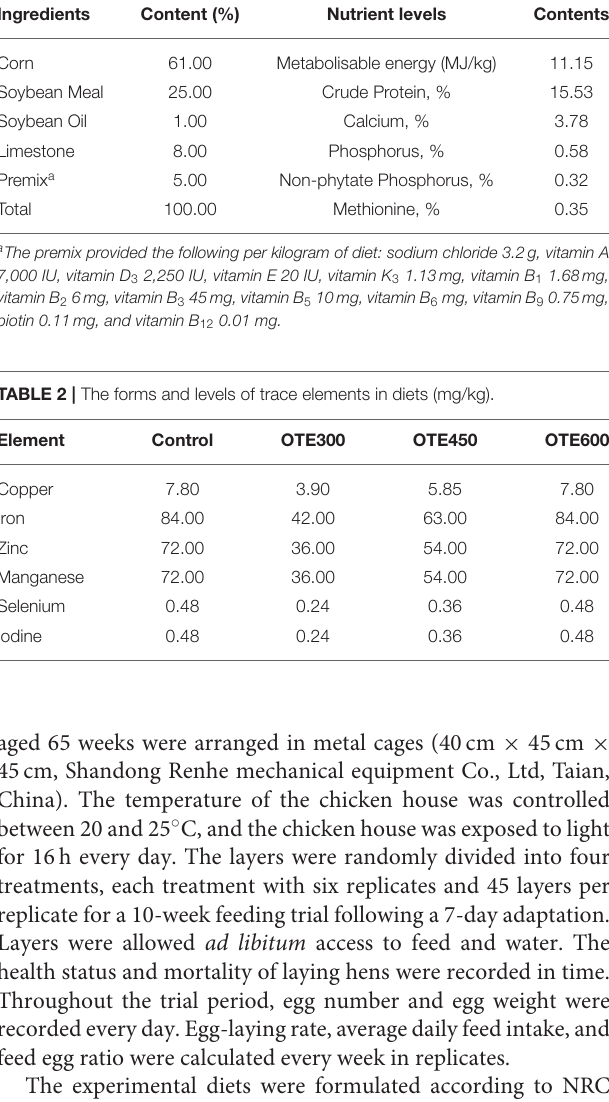
TABLE 1 | Dietary components and nutrient levels in the basal diet (as fed-basis). Ingredients